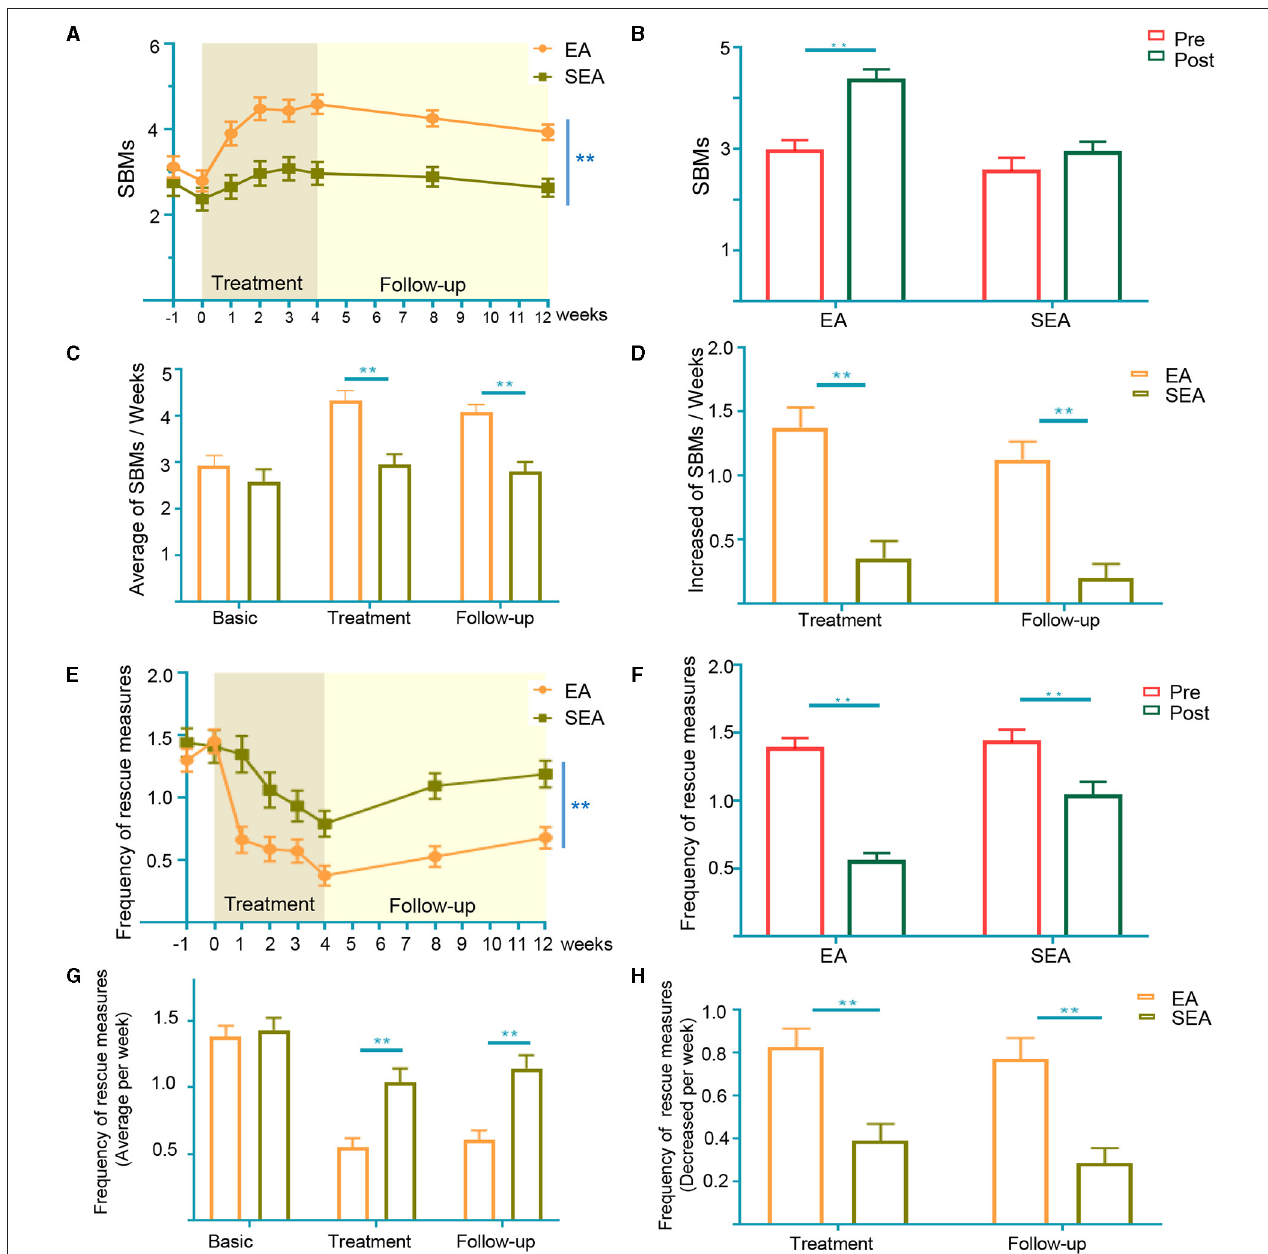
FIGURE 2 | Changein SBMs and frequency of enema uses per week. (A) SBMs per week in the entire trial. Two-way analysis of variance (ANOVA); (B) SBMs in pre- and post-treatment period. The data of pre-treatment generated from the average of the basic period ( − 1 and 0 week in A ). The data of post-treatment generated from the average of the treatment period (1–4week in A ); (C) mean weekly SBMs at baseline, treatment period and follow-up period; (D) increase in SBMs of treatment period and follow-up period from baseline; (E) frequency of enema uses per week in the entire trial. Two-way analysis of variance (ANOVA); (F) frequency of rescue measures in pre- and post-treatment period. The data of pretreatment generated from the average of the basic period ( − 1 and 0 week in A ). The data of post-treatment generated from the average of the treatment period (1–4week in A ); (G) mean weekly frequency of enema uses at baseline, treatment period, and follow-up period; (H) decrease in frequency of laxative rescue measures uses during treatment and follow-up periods from baseline. SBM, spontaneous bowel movements. Error bar is presented as mean ± standard derivation error, Baseline: 2 weeks (Week − 1 to Week 0). Treatment: 4 weeks (Week 1 to Week 4). Follow-up: 8 weeks (Week 5 to Week 12). * p < 0.05, ** p < 0.01, Mann Whitney test.